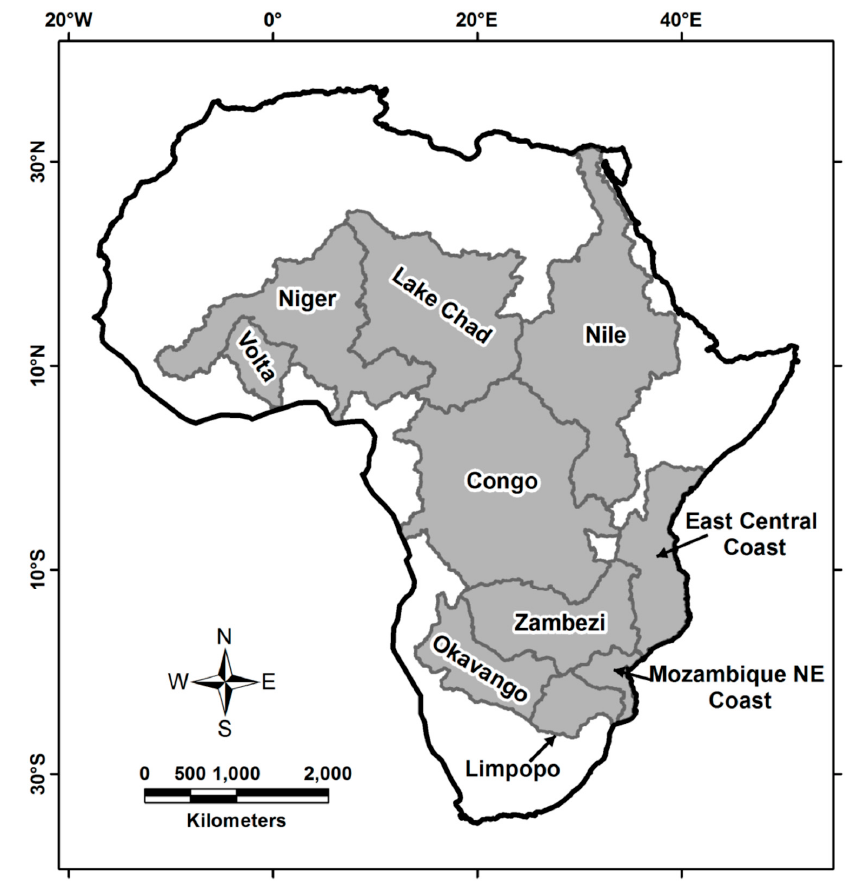
Figure 1. Distribution of the investigated 10 watersheds in Africa.